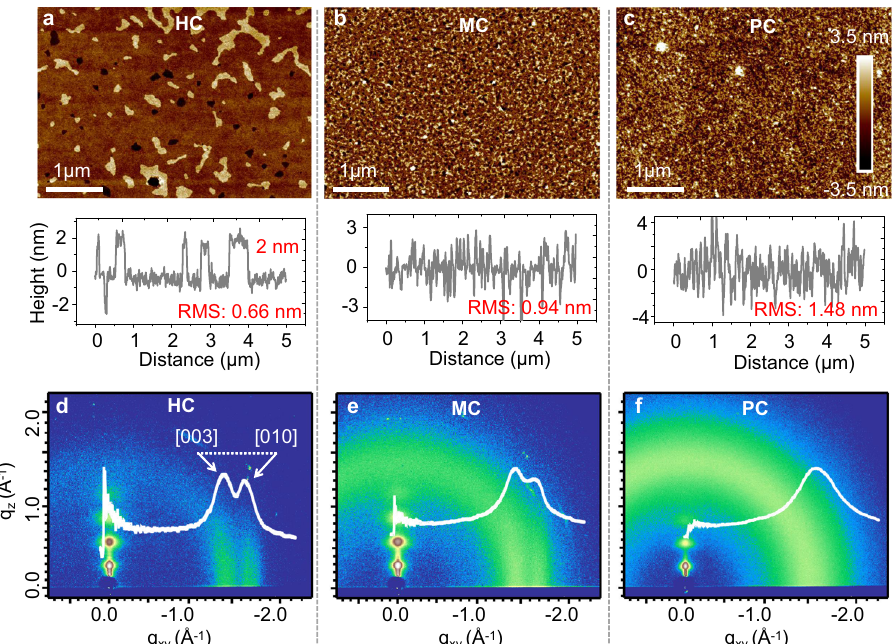
Fig. 1 Crystalline morphology of PBTTT fi lms. AFM characterization of polymer samples with different crystalline degrees. Surface morphology of highly crystalline (HC), moderately crystalline (MC) and poorly crystalline (PC) samples in a , b , and c , respectively. The surface section is displayed, with root mean square (RMS) values of surface roughness. The scale bar is 1 µ m. GIWAXS for samples of different crystalline degrees, 2D diffraction images for HC ( d ), MC ( e ), and PC ( f ) samples, with the in-plane diffraction data displayed by the white curves, the peaks [003] and [010] are